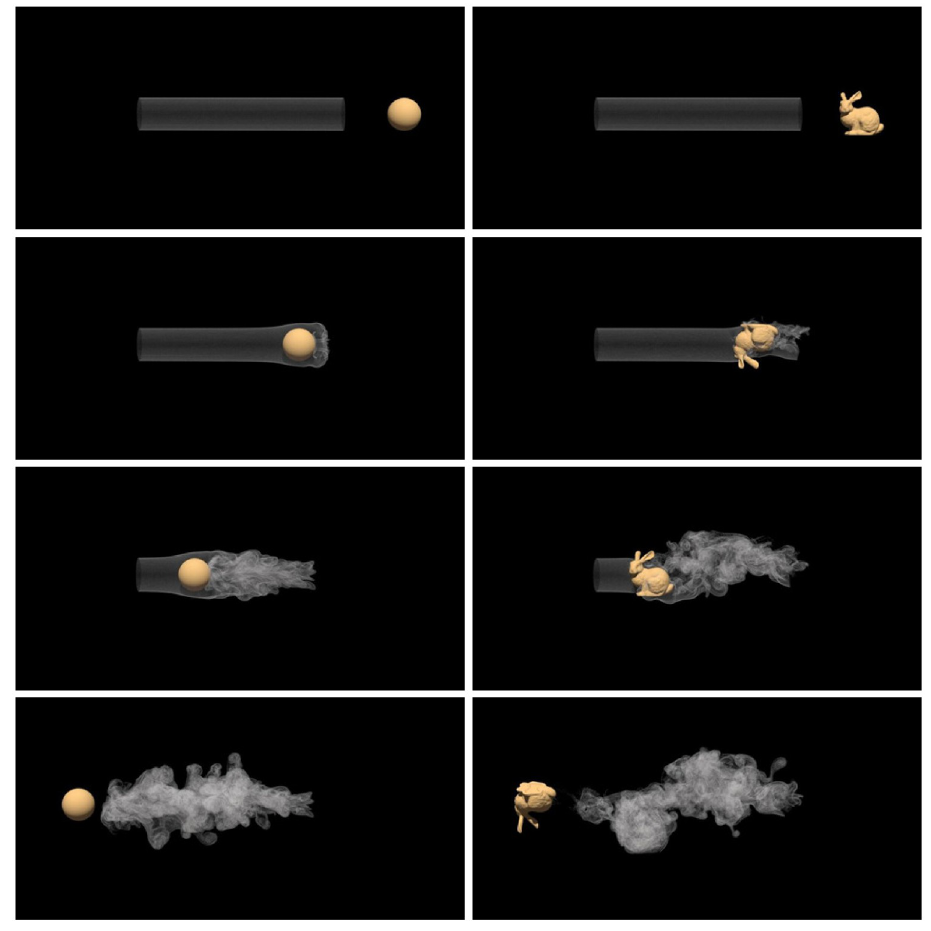
Fig 14. Moving object passing through smoke. The first column is a translation ball. The second column is a bunny with translation and rotation.